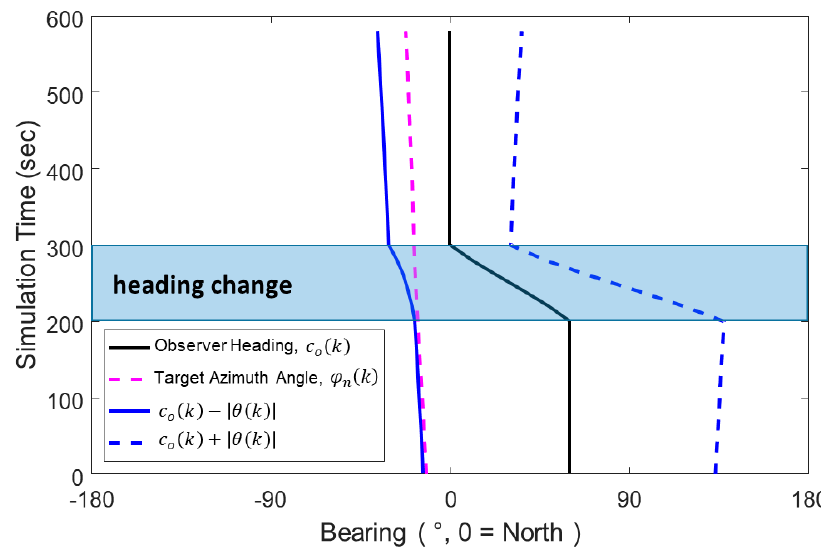
Figure 4. Bearing-time records (BTRs) of the scenario.